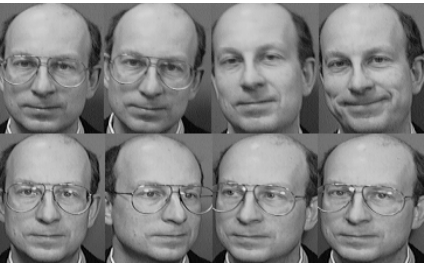
Figure 13. Example from the ORL face database.